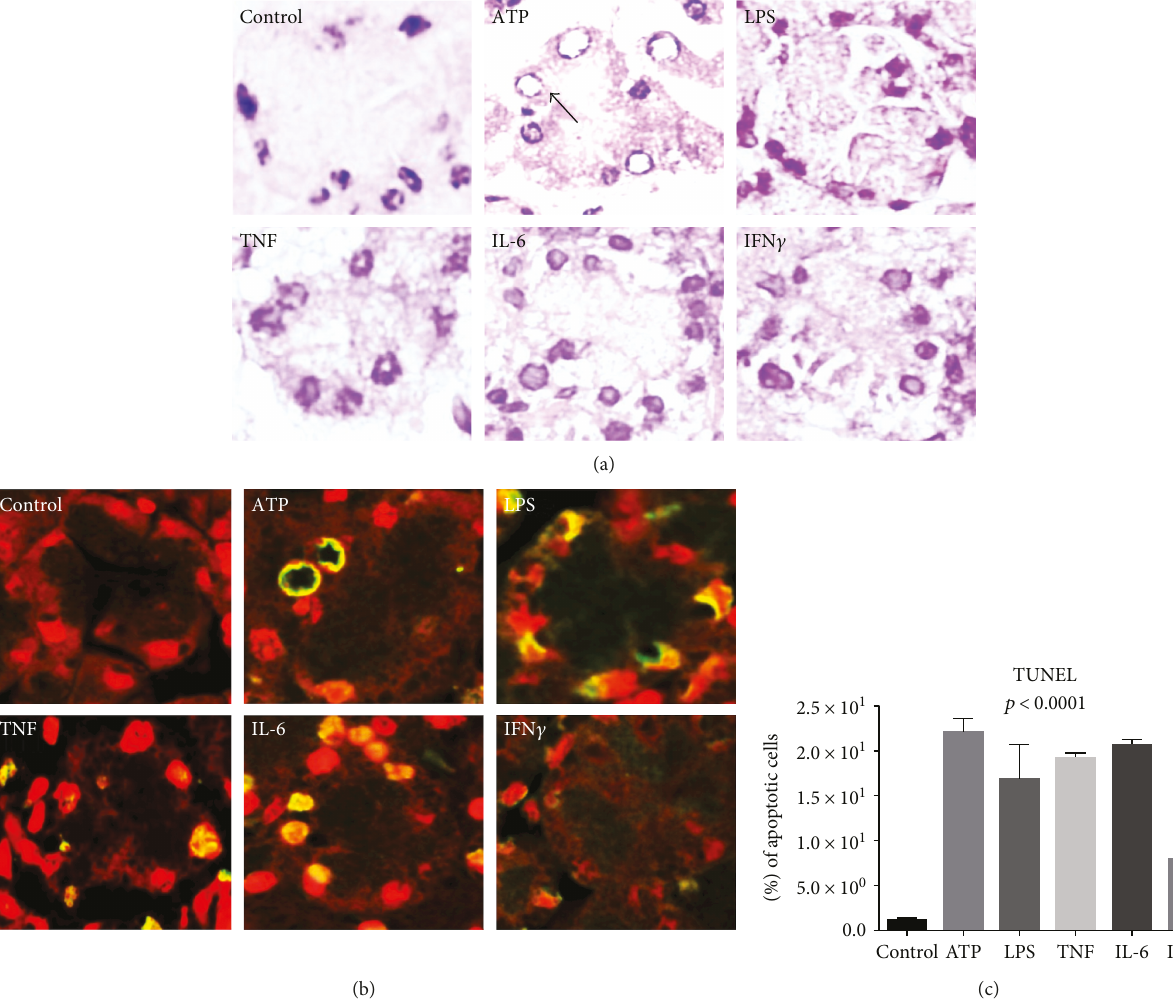
Figure 1: Molecular stimulants induce changes in salivary glands. (a) Morphology of H&E-stained salivary glands from Balb/c mice. (b) TUNEL assay (lower panel) showing apoptotic changes in green or yellow in response to di ff erent triggers. Nonapoptotic cells were counterstained red with propidium iodide. (c) The graph shows the percentage of apoptotic cells ( p value calculated by